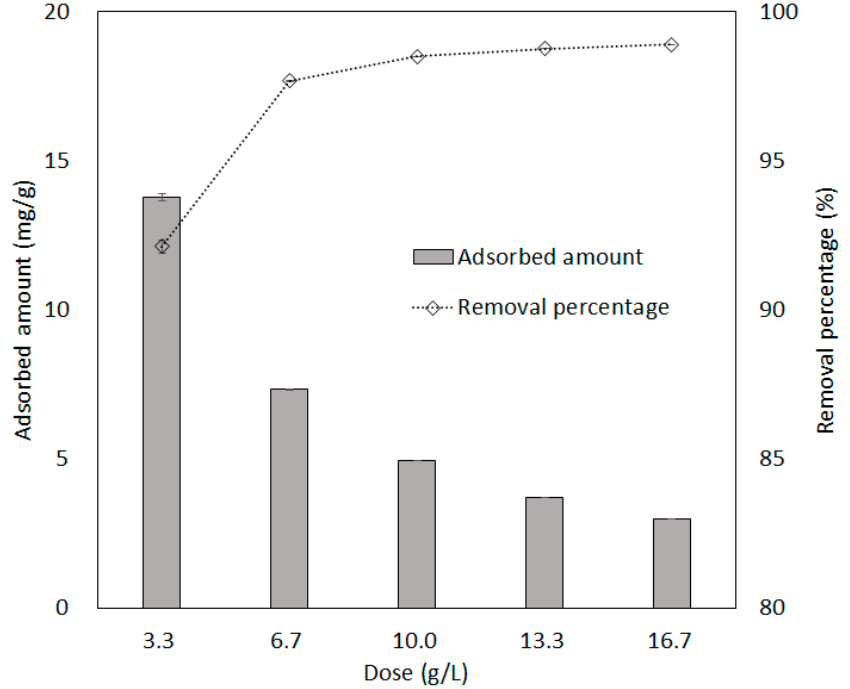
Figure 6. Effect of Fe-CMB dose on the adsorbed amount of Sb(V) per unit mass of adsorbent (mg/g) and their corresponding removal percentage (%).